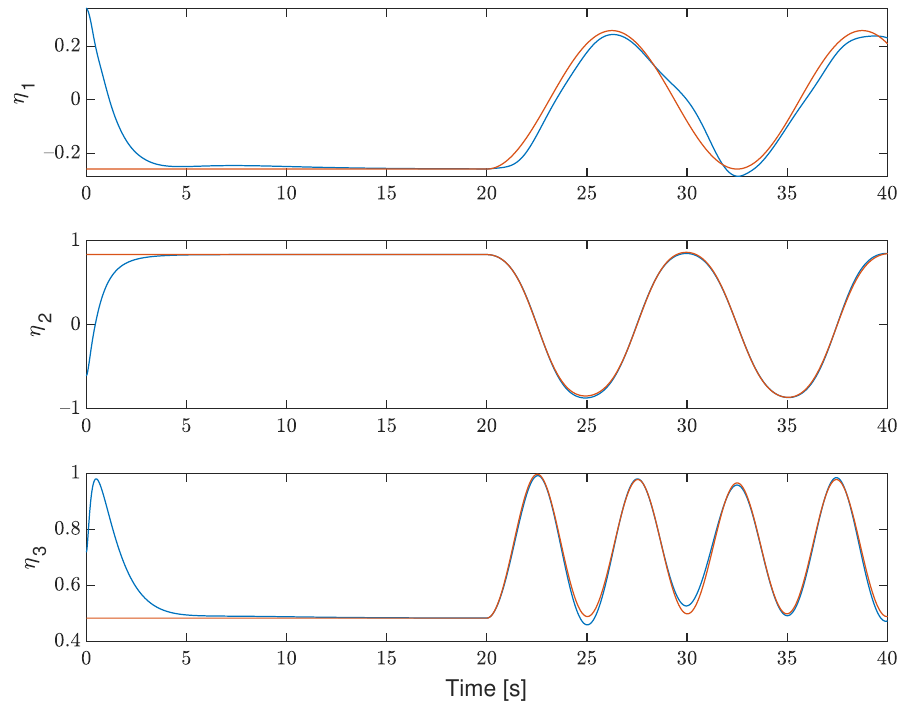
Figure 6. Reduced attitude η (blue) and the reduced-attitude reference η d